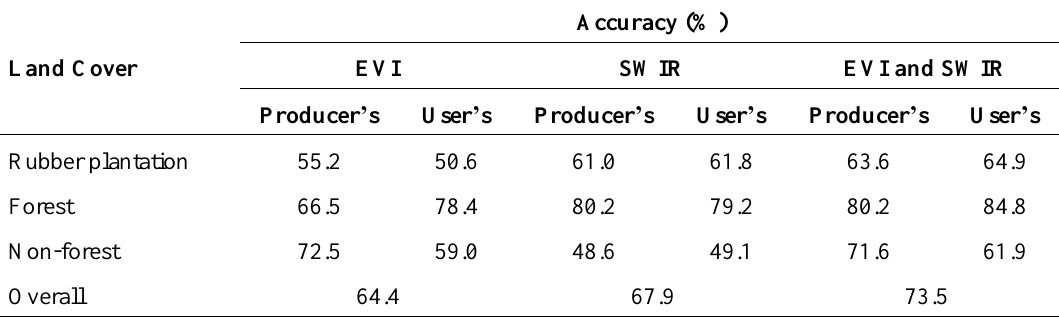
Table 2. Overall producer’s and user’s accuracies for the three models based on phenological metrics.